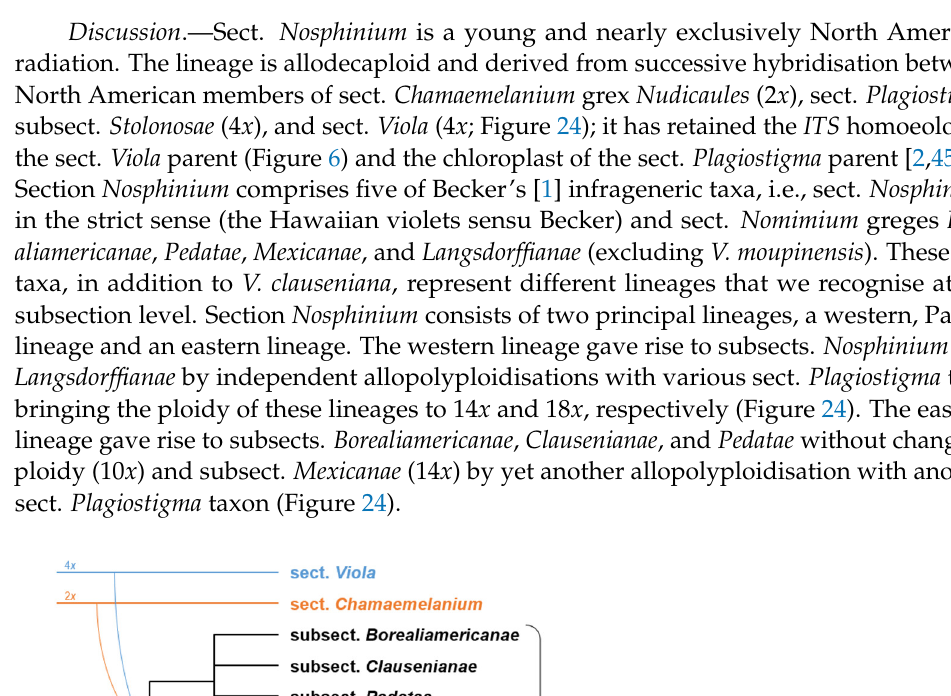
Figure 23. Global distribution of Viola sect. Nosphinium .